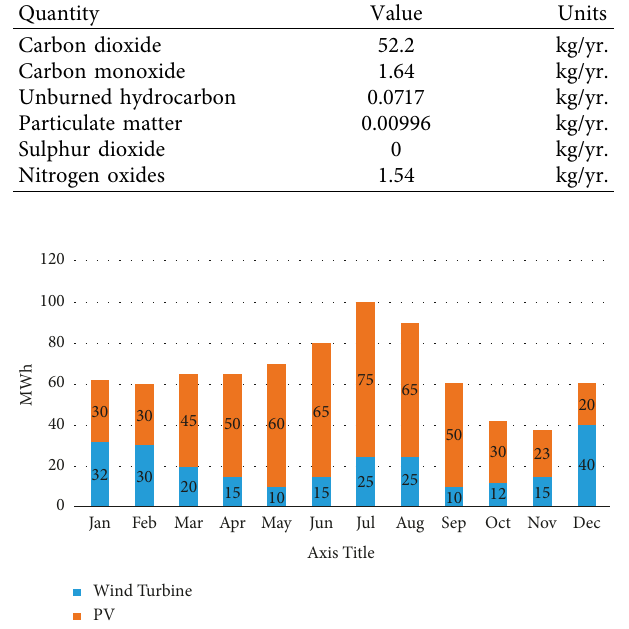
Figure 7: Monthly electric production in different months of the year (Scenario 4).